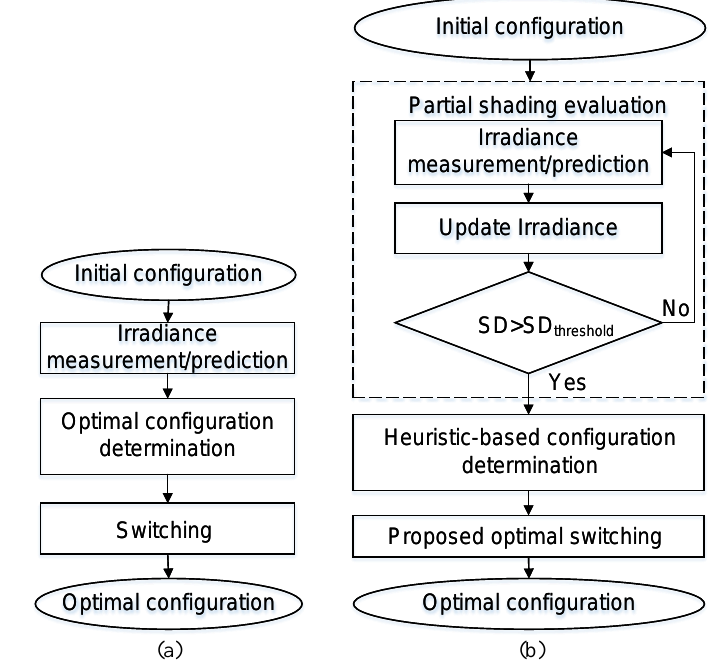
Figure 3. ( a ) Traditional DPVAR framework. ( b ) Proposed DPVAR